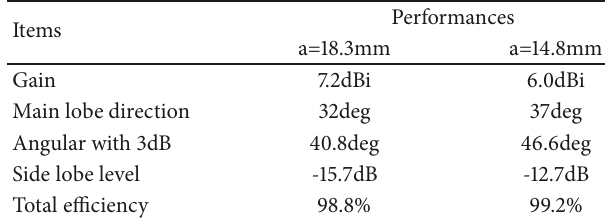
Table 2: Parameters of